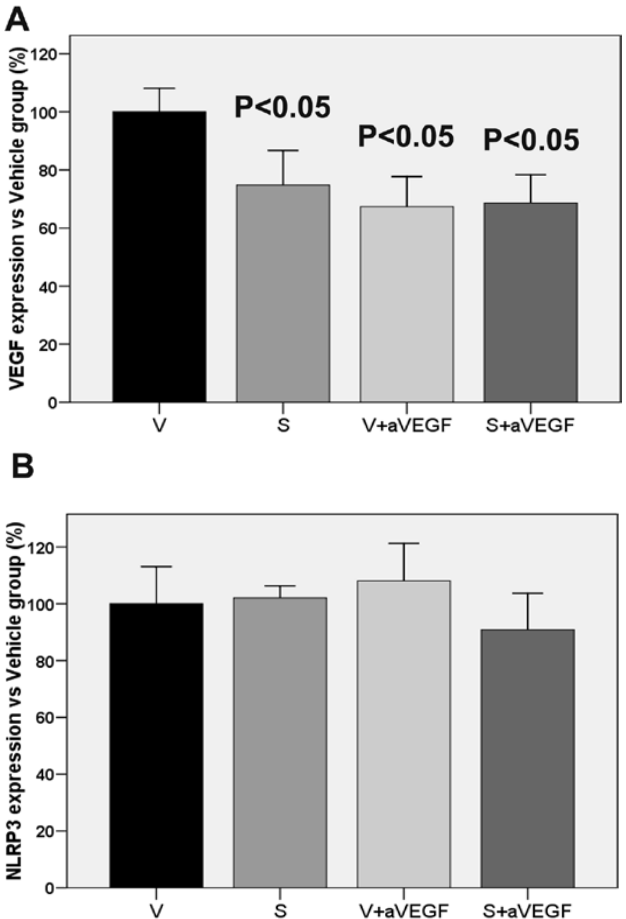
10 Figure 4. Choroidal neovascularization (CNV) detection by CD31 immunofluorescence. Mice that received only the vehicle (upper left, group V) had larger areas of CNV than